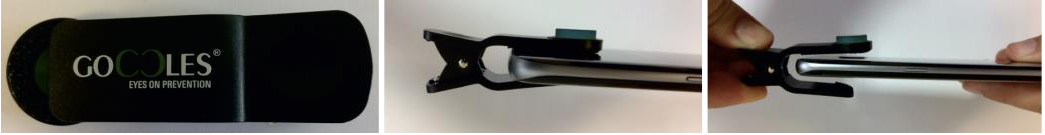
Figure 1. The GOCCLES ® clip (Glasses for Oral Cancer Curing Light Exposed Screening) medical device. The same lesions were, subsequently, evaluated using blue toluidine staining, ac- classified as Dark Royal Blue (positive) or Pale Royal Blue (negative)